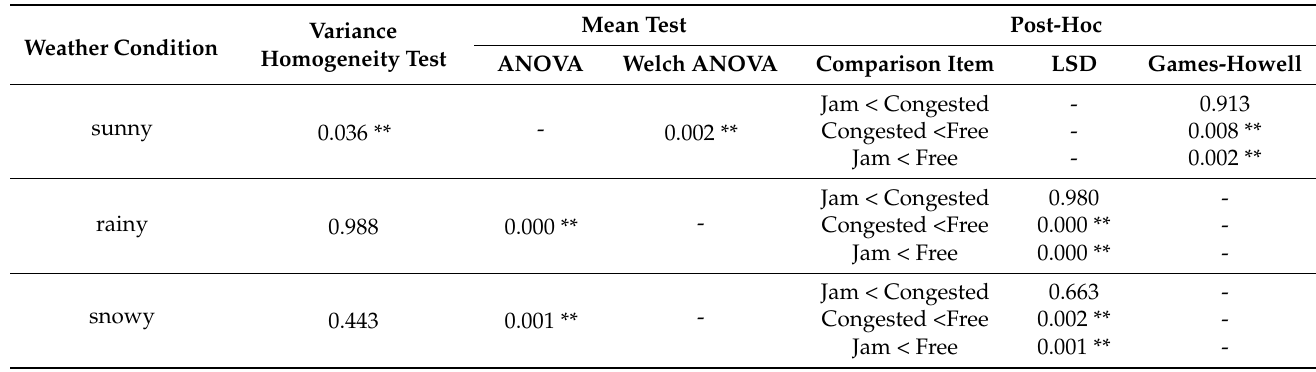
Table 12. Significance test of the effect of traffic flow on the maximum lateral offset.